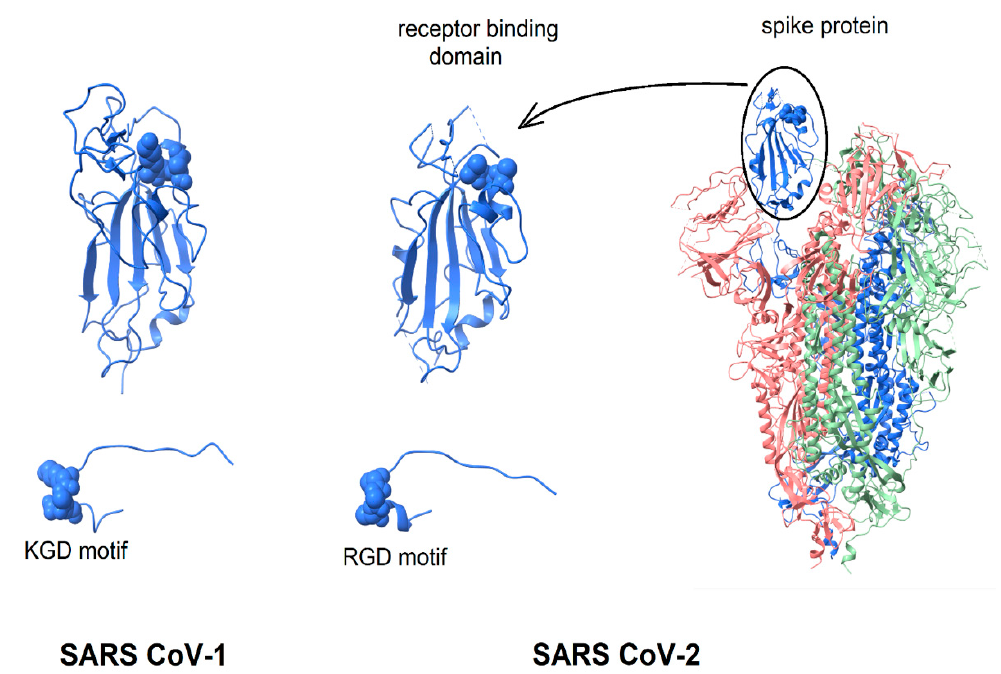
Figure 1. Display of integrin-binding motifs on coronavirus spike proteins. In each image, the integrin-binding motif is rendered in “space filling mode” and the remainder of the protein in ribbons. SARS CoV-1 (left) contains a KGD motif; SARS CoV-2 an RGD motif. Left to right: SARS CoV-1 receptor-binding domain (6acd); SARS CoV-2 receptor-binding domain (6vsb); SARS CoV-2 spike protein (6vsb). The three chains of the trimer are colored blue, green and pink. The RGD/KGD motif is at or near the protein surface. Adjacent surface loops would need to move to allow binding to an integrin. The protein segment containing the RGD/KGD motif has been dissected from the remainder of the protein and enlarged to show that in both SARS CoV-1 and SARS Cov-2 spike proteins, the RGD/KGD motif is at a tight bend where the peptide chain reverses direction, similar to known integrin-binding molecules.